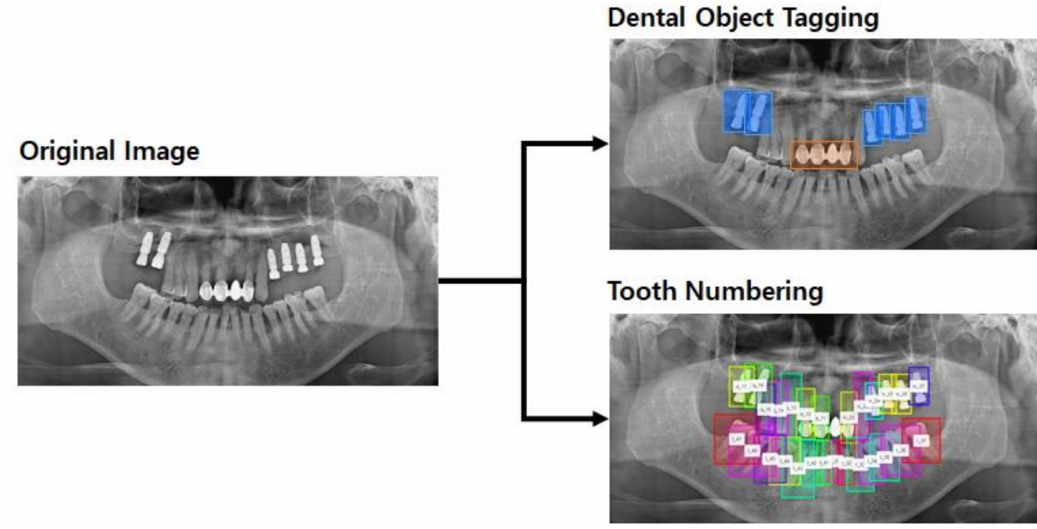
Figure 6. Example of labeled